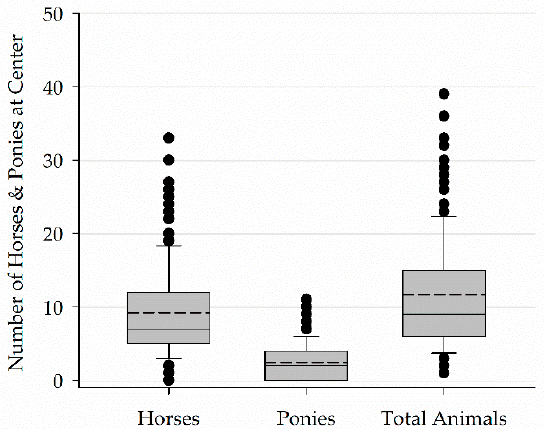
Figure 4. Number of horses and ponies in centers offering EAS programming. Horses and ponies ranged in age from less than 5 years to 36 to 40 years with the greatest percentage (33, 20–44%) falling between 16 and 20 years of age (Figure 5).